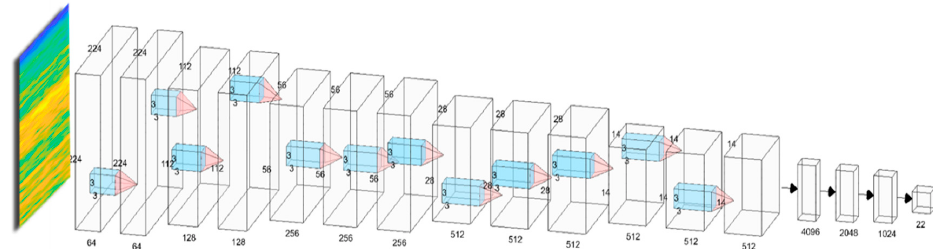
Figure 3. Applied VGG16 architecture for classifying spectrogram images.